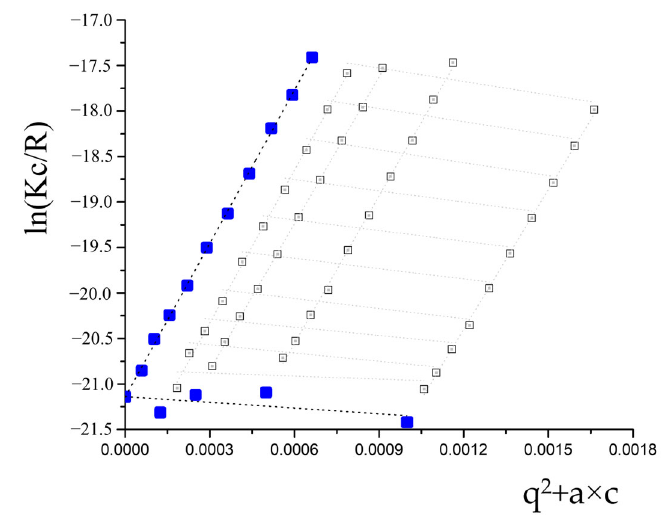
Figure 2. Guinier plot for the PNIPAM ‐ PAA microgel. White squares correspond to experimental data, blue squares correspond to calculated approximations.